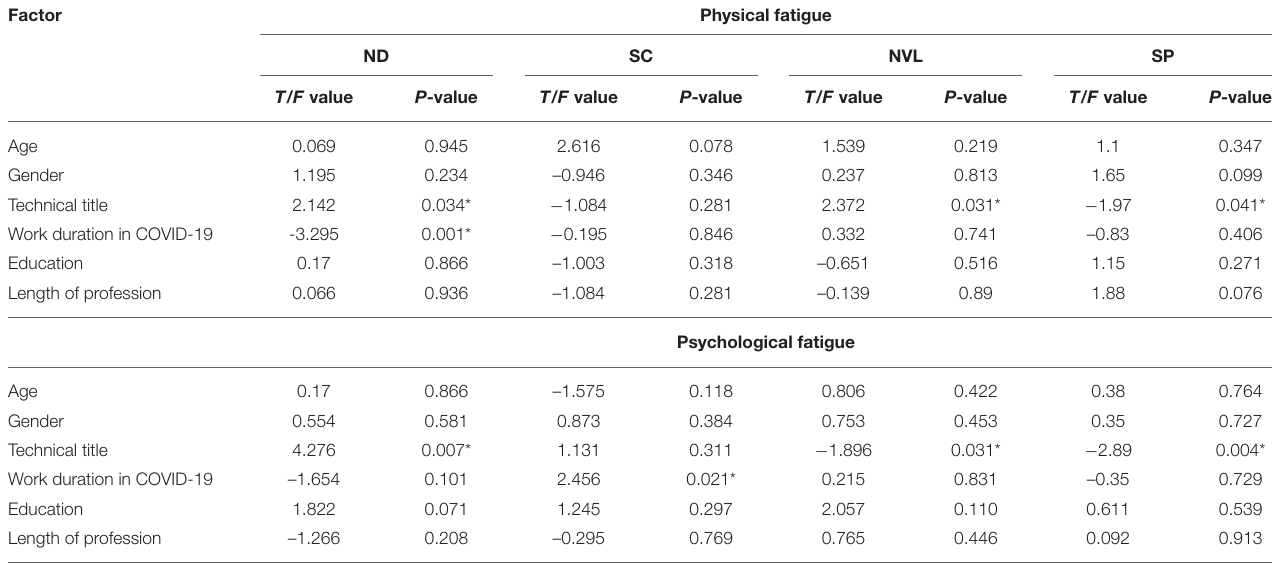
TABLE 6 | Social-demographic characteristics by the environmental factors.